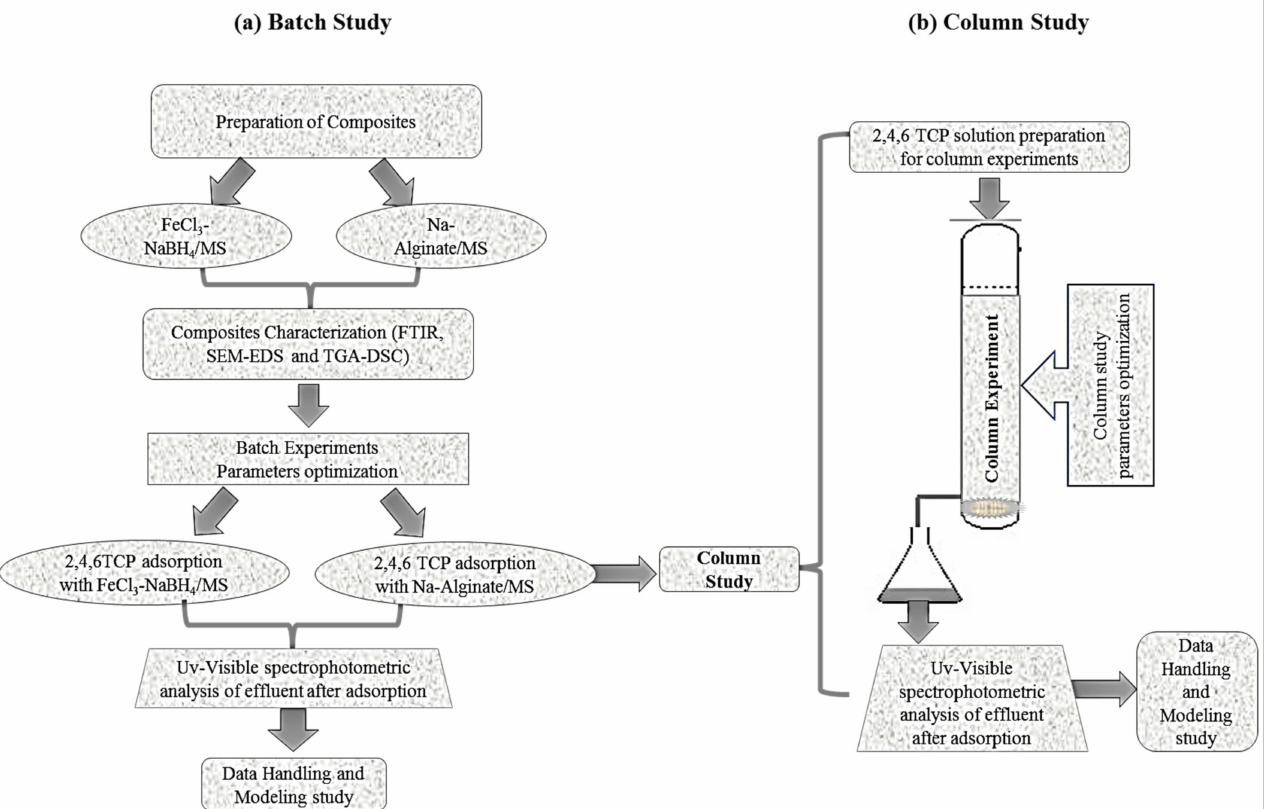
Figure 6. Flow sheet diagram for ( a ) Batch study experiments and ( b ) column study